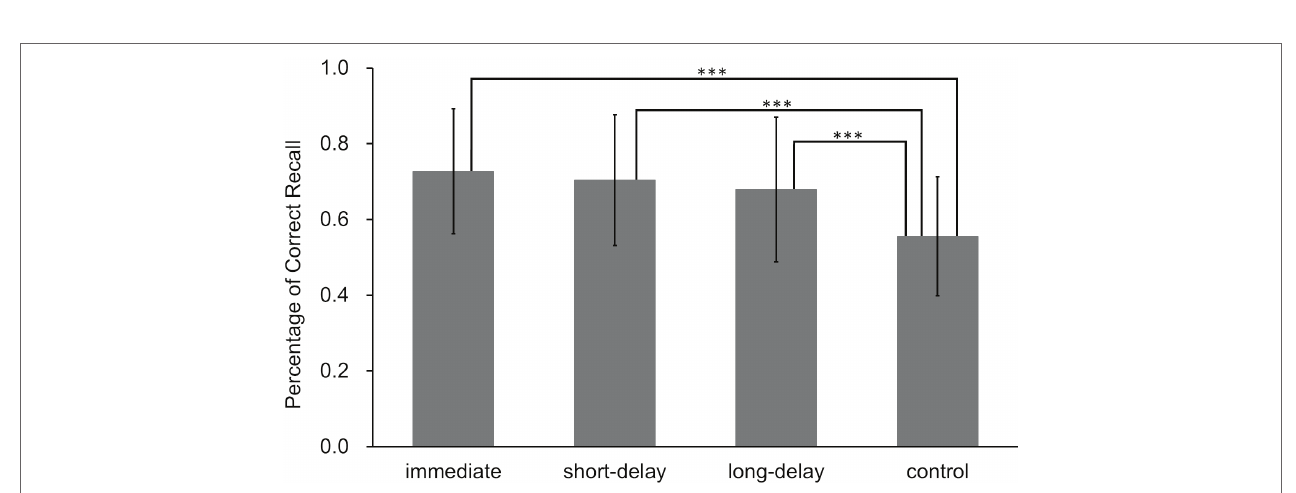
FIGURE 6 | Final test performance for each learning condition in Experiment 1 (error bars represent SD ); a one-factor analysis of variance revealed significant differences between each of the conditions connected by a straight line (*** p < 0.01).